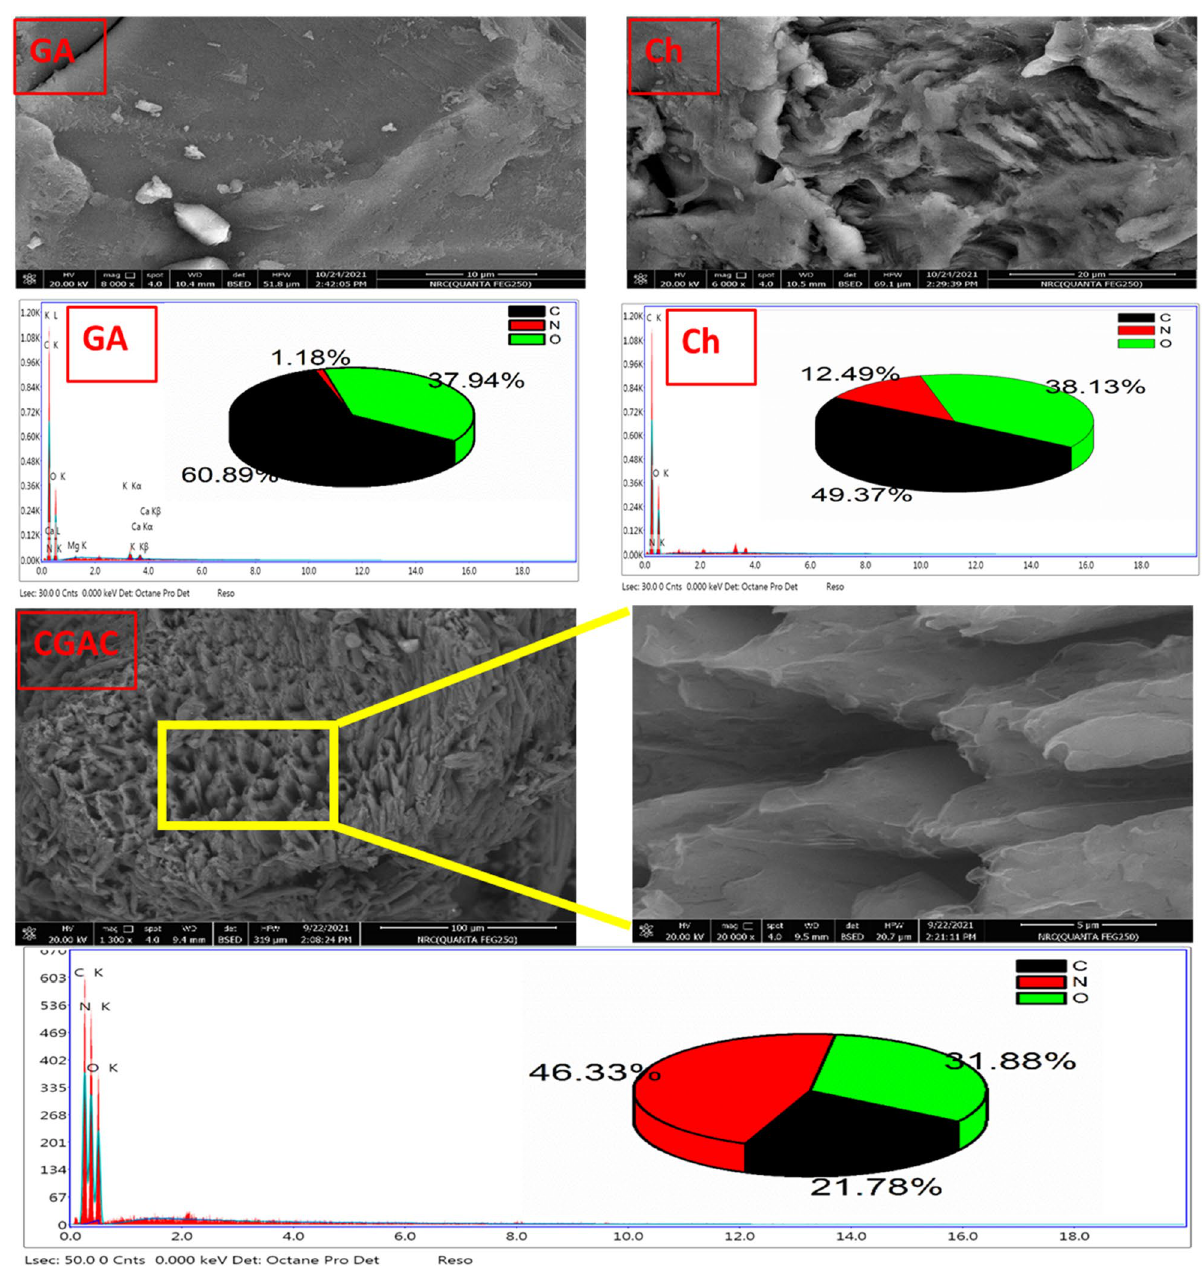
Figure 5. SEM images as well as EDX charts of the two raw materials (upper) and the CGAC nanopowder